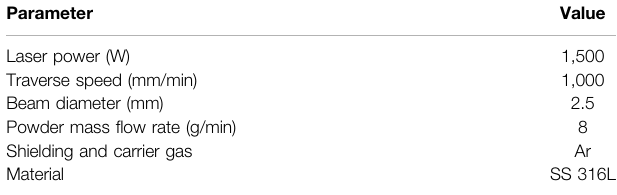
TABLE 2 | Experimental process parameters for laser